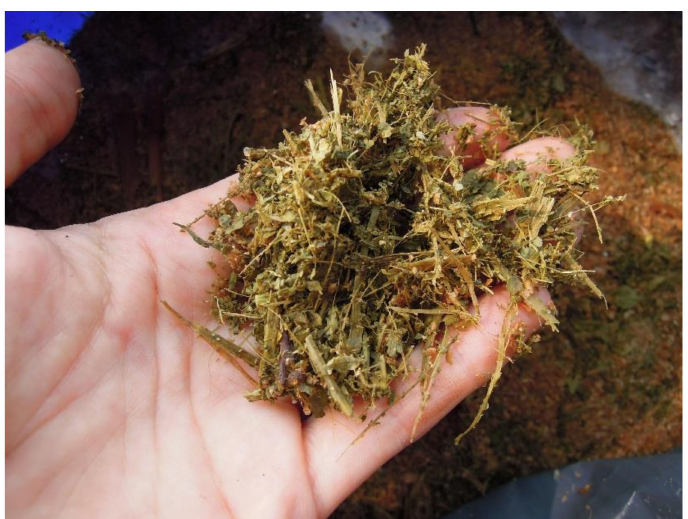
Figure 2. Fermentation-based organic fertilizer from the aboveground parts of F. japonica .